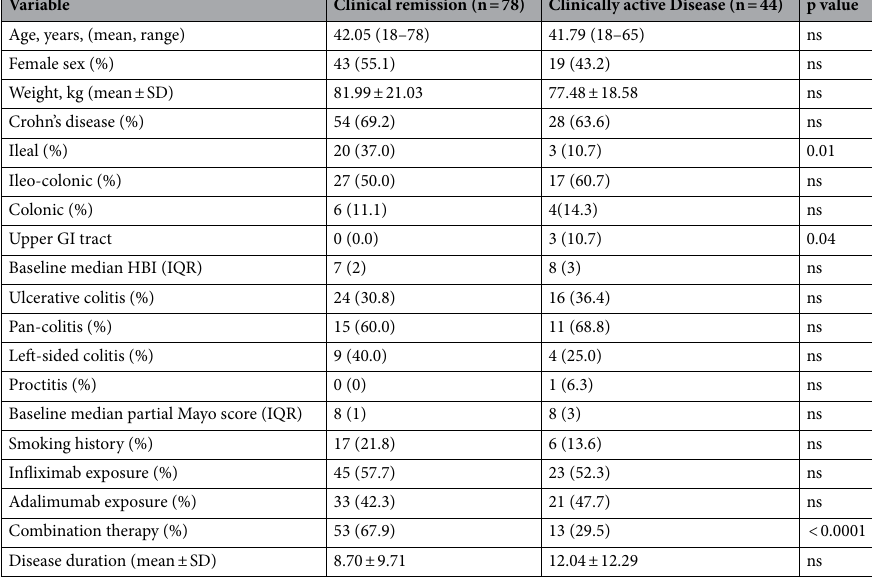
Table 2. Demographic characteristics by disease activity. Not significant, ns; kilogram, kg; standard deviation, SD; gastrointestinal, GI; Harvey Bradshaw Index, HBI; interquartile range,